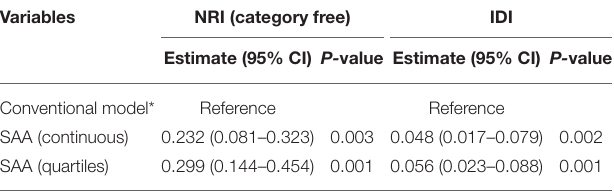
Frontiers in Neurology |